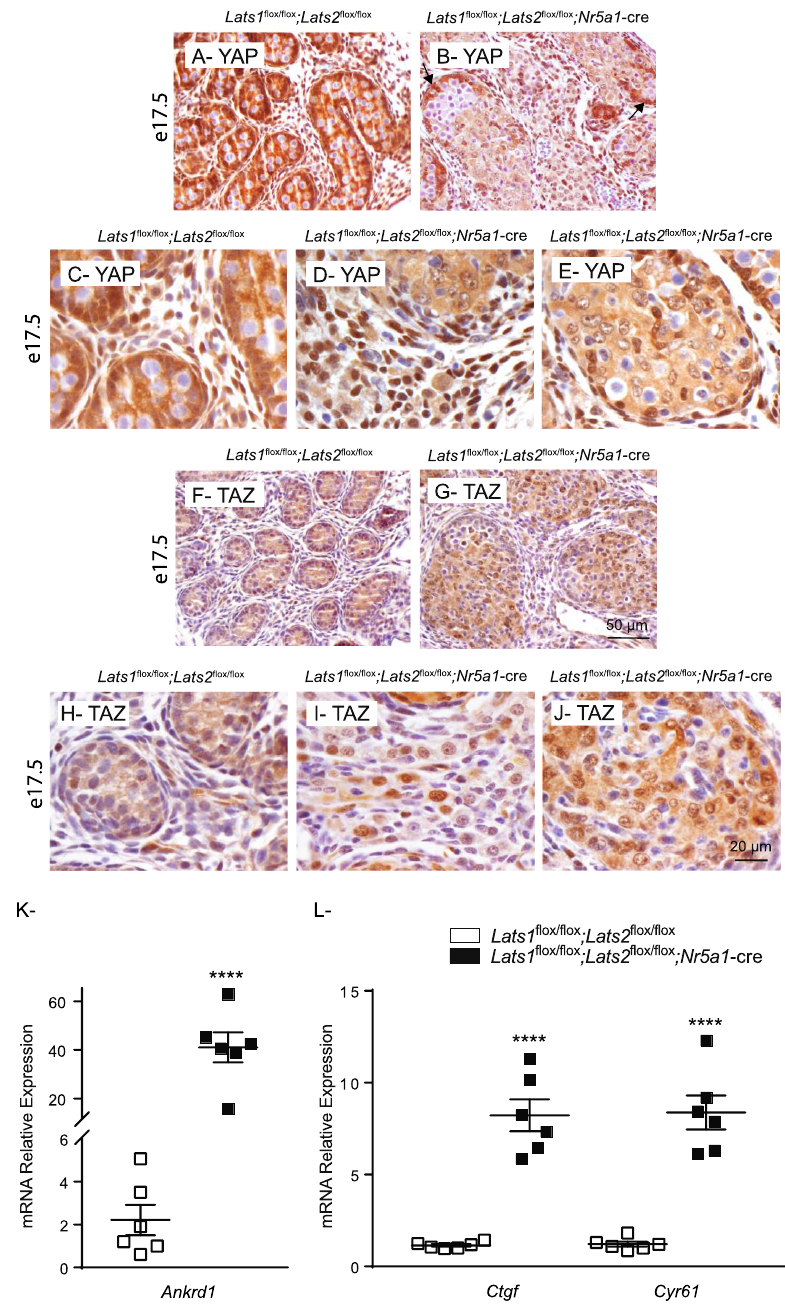
Figure 4. YAP/TAZ activity increases in the testes of Lats1 flox/flox ; Lats2 flox/flox ; Nr5a1 cre/+ mice. ( A – E ) Immunohistochemical analysis of YAP expression in testes of e17.5 mice of the indicated geno- types. ( F – J ) Immunohistochemical analysis of TAZ expression in testes of e17.5 mice of the indicated genotypes. Arrow = YAP expression in non-recombined Sertoli cells. Scale bar in ( G ) is valid for ( A , B , F ). Scale bar in ( J ) is valid for ( C – E , H , I ). ( K , L ) RT-qPCR analysis of YAP/TAZ downstream tar- gets mRNA levels in the testes of e17.5 mice of the indicated genotypes ( n = 6 animals/genotype). All data were normalized to the housekeeping gene Rpl19 and are expressed as means (columns) ± SEM (error bars). Asterisks = significantly different from control (**** p <